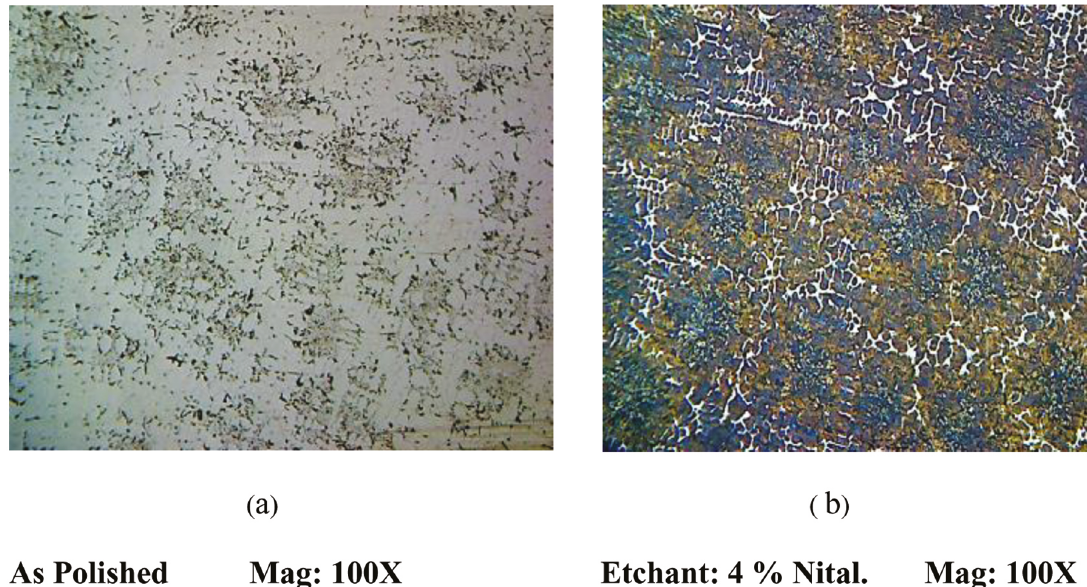
Figure 4. Microstructure analysis of cylinder